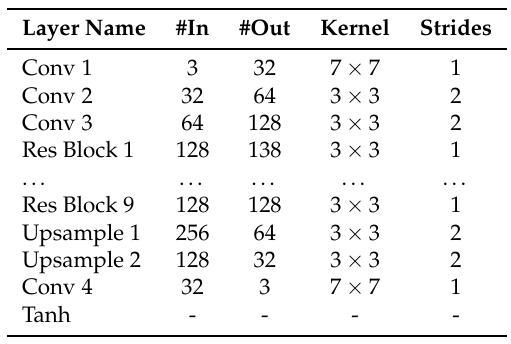
Table 1. Main parameters of our generator. ‘#In’ denotes the number of input channel, and ‘#Out’ represents the number of output channel. ‘Upsample’ denotes the resize convolution.